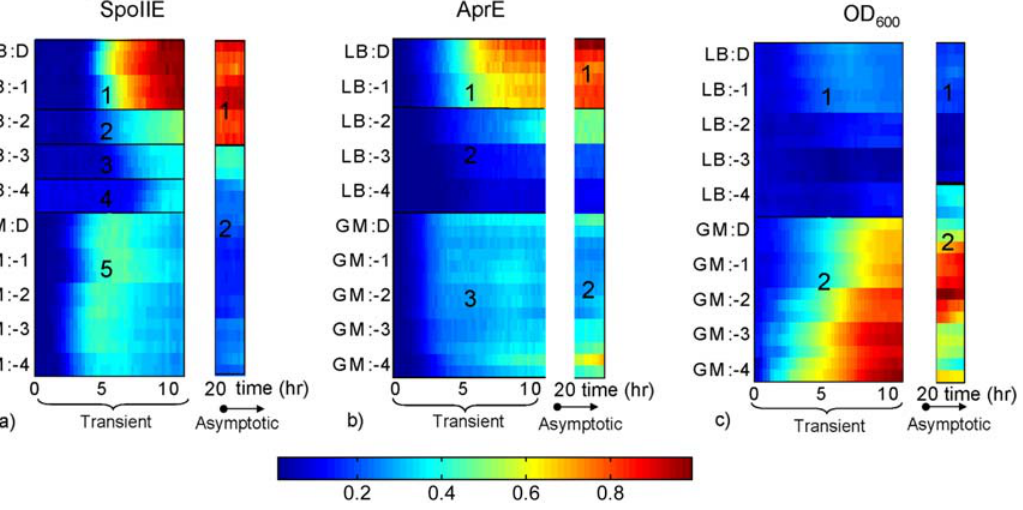
Figure 6. The map from cell history to B.subtilis stress response clusters. The transient dynamics and long-term levels of the sporulation initiation (P spoIIE-gfp expression), AprE synthesis (P aprE-dsred expression), and growth (OD 600 ) signals were clustered using the automatic method in Materials and Methods. This figure shows the heat maps for each signal in Figure 5 (dark red indicates maximum, and dark blue minimum), the number of behavioral classes for each signal, and which subset of the ten cell histories in our test set corresponds to each cluster. For example, the asymptotic sporulation initiation signal from P spoIIE - gfp fusion clustered into two classes, one (top, 1) corresponding to a history of growth in rich LB medium to the three highest densities, D, 2 1, and 2 2, and the other class (bottom, 2) corresponding to all other cell